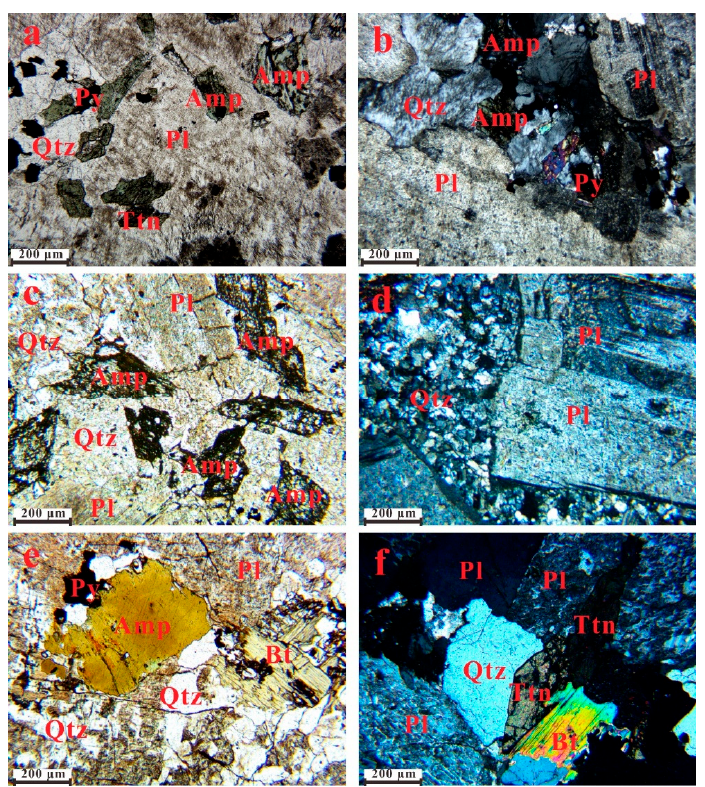
Figure 3. Photomicrographs of the Yueshan, Zongpu and Dalongshan intrusive rocks in the Anqing orefield. The Yueshan quartz diorite shows Amp + Pl + Qtz and accessory titanite and pyrite; plane polarized light ( a ) and cross polarized light ( b ). The Zongpu quartz diorite mainly composed of plagioclase, perthite, quartz and amphibole, shown in plane polarized light ( c ) and cross polarized light ( d ). The Dalongshan quartz granite porphyry showing plagioclase, quartz, biotite and amphibole in plane polarized light ( e ) and cross polarized light ( f ). Amp: amphibole, Bt: biotite, Pl: plagioclase, Py: pyrite, Qtz: quartz, Ttn: titanite.